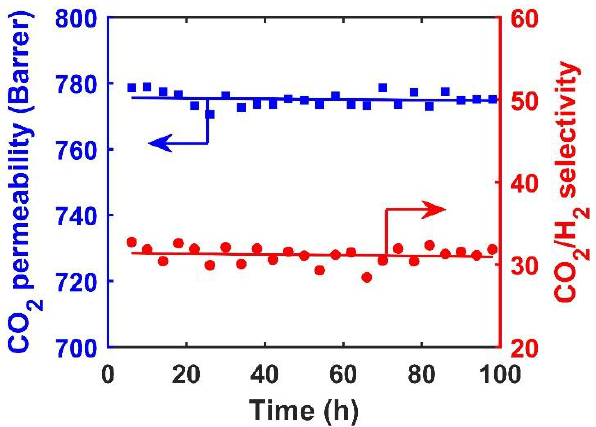
Figure 11. Stability of membrane with 10 wt.% AF-MWNTs at 107 °C and 1.5 MPa: CO 2 permeability ( ) and CO 2 /H 2 selectivity ( ● ).